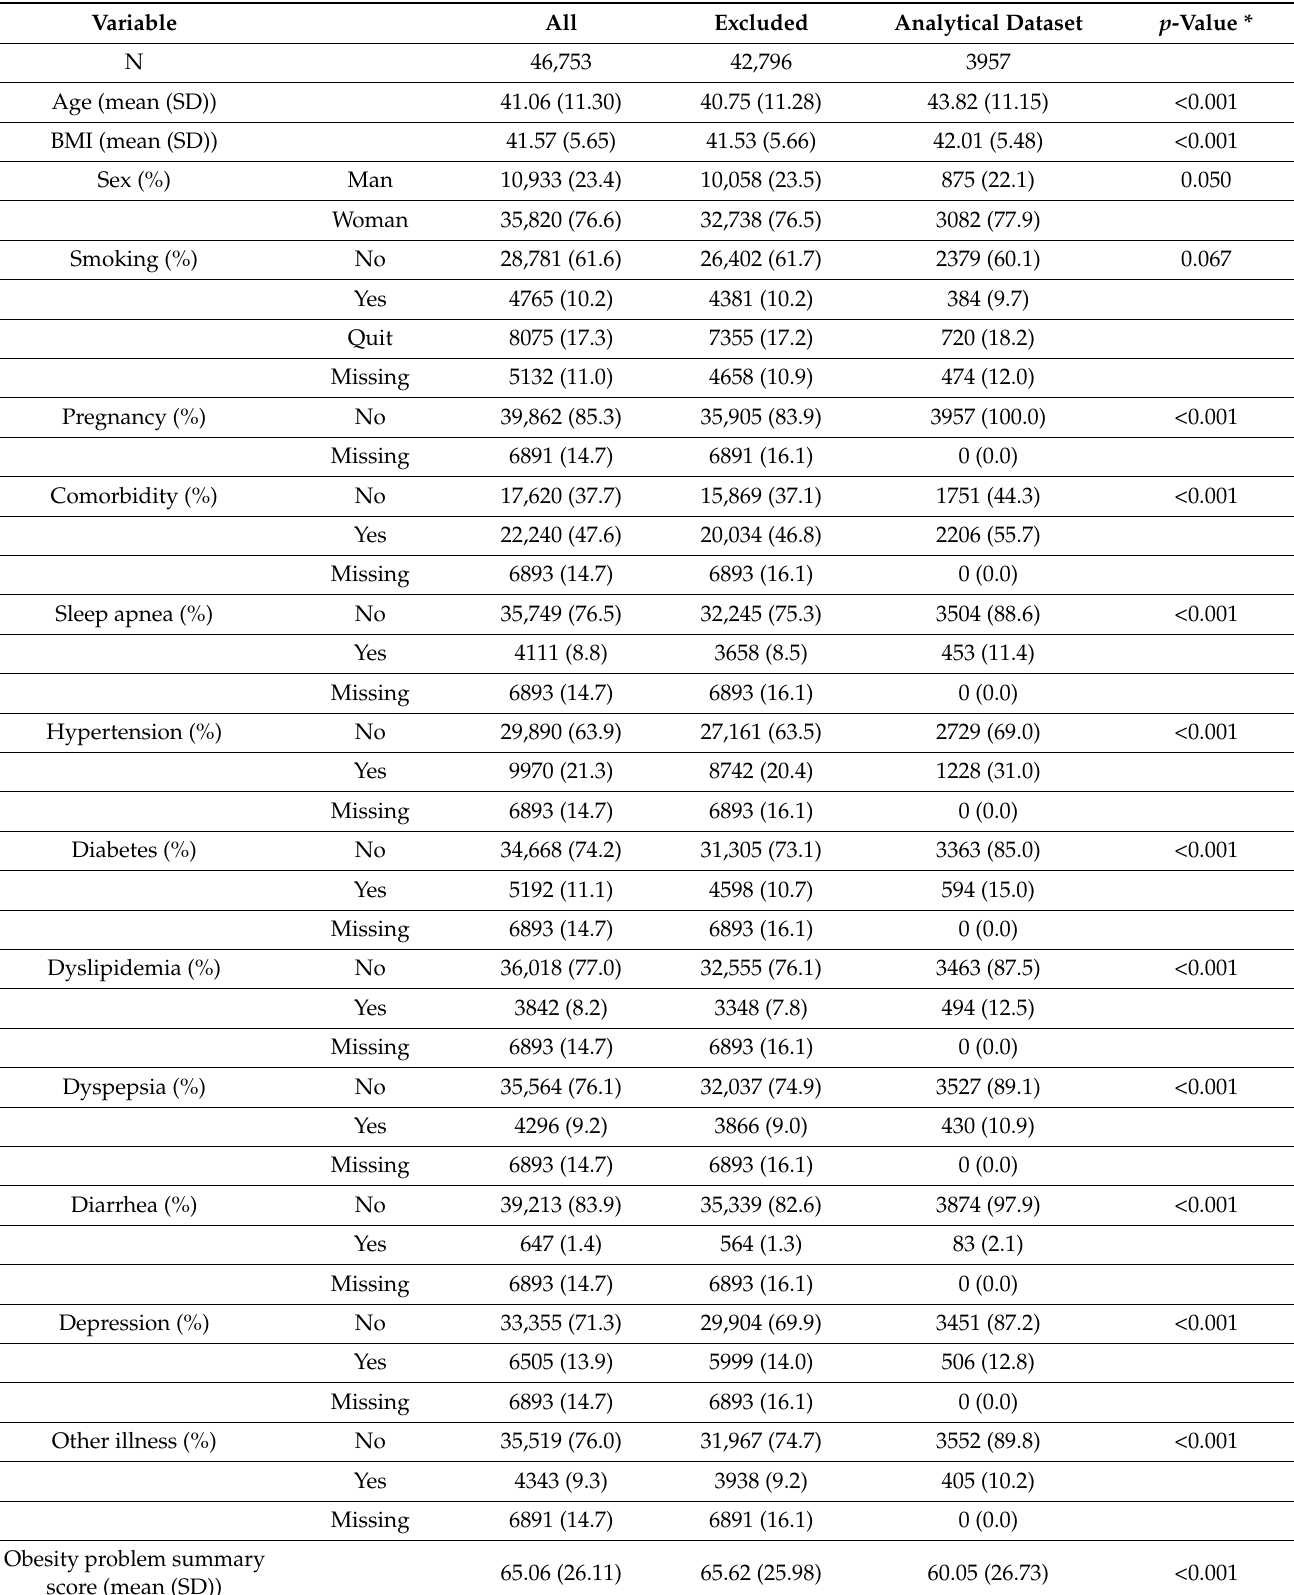
Table 1. Demographic characteristics of the patients at